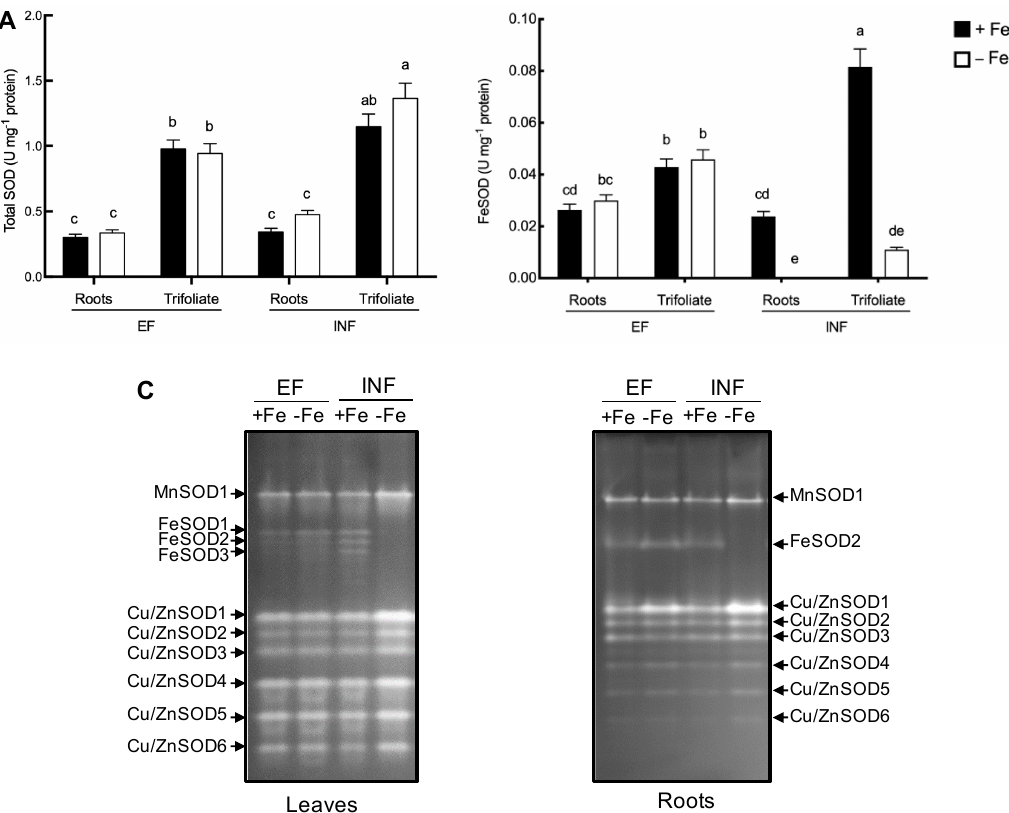
Figure 6. Root FRO activity (nmol Fe/g FW h) of efficient (EF) and inefficient (INF) soybean lines grown under Fe sufficiency (+Fe, 20 µM) or Fe deficiency ( − Fe, no Fe) for 14 days under hydroponic conditions. Data are means ± SE; different letters indicate significant differences ( p < 0.05) by ANOVA with Tukey correction test.